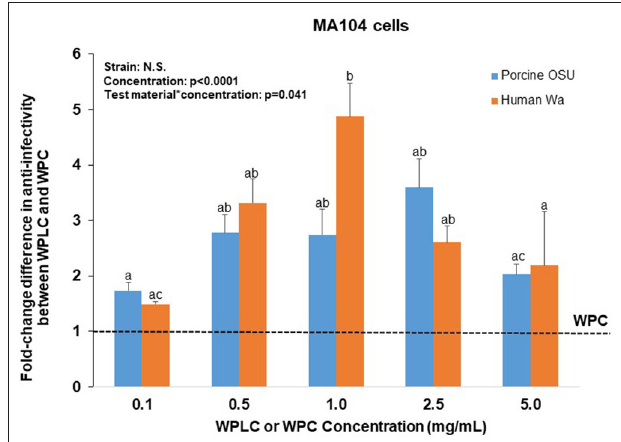
FIGURE 2 | Fold-change difference in anti-RV activity of WPLC and WPC when MA104 cells were infected with porcine RV OSU or human RV Wa. Fold-change represents the ratio between WPC and WPLC efficacy to reduce % infectivity at each concentration tested. Data are represented as means ± SEM of three separate experiments. Unlike letters represent significant differences ( p < 0.05) among concentrations. The largest difference in efficacy of WPLC over WPC to reduce infectivity of OSU and Wa strains was found at concentrations 1.0 and 2.5 mg/ml in MA104 cells. RV, rotavirus; WPC, whey protein concentrate; WPLC, whey protein lipid concentrate.